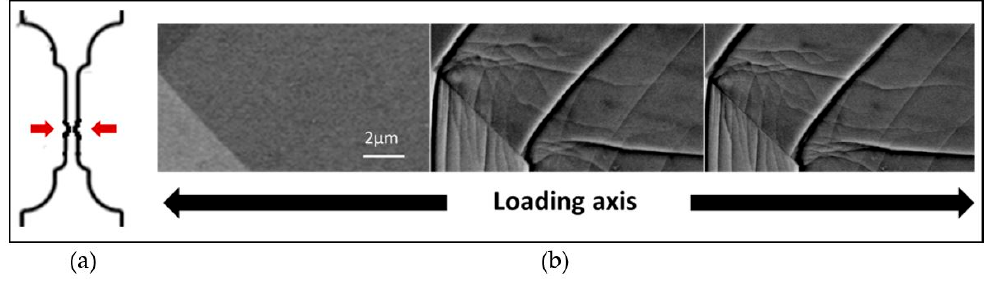
Figure 6. ( a ) Local section reduction to create high-strained zones ( b ) BSE micrographs in channeling condition post mortem test showing dislocation networks and slip lines forming and evolving during plastic deformation.